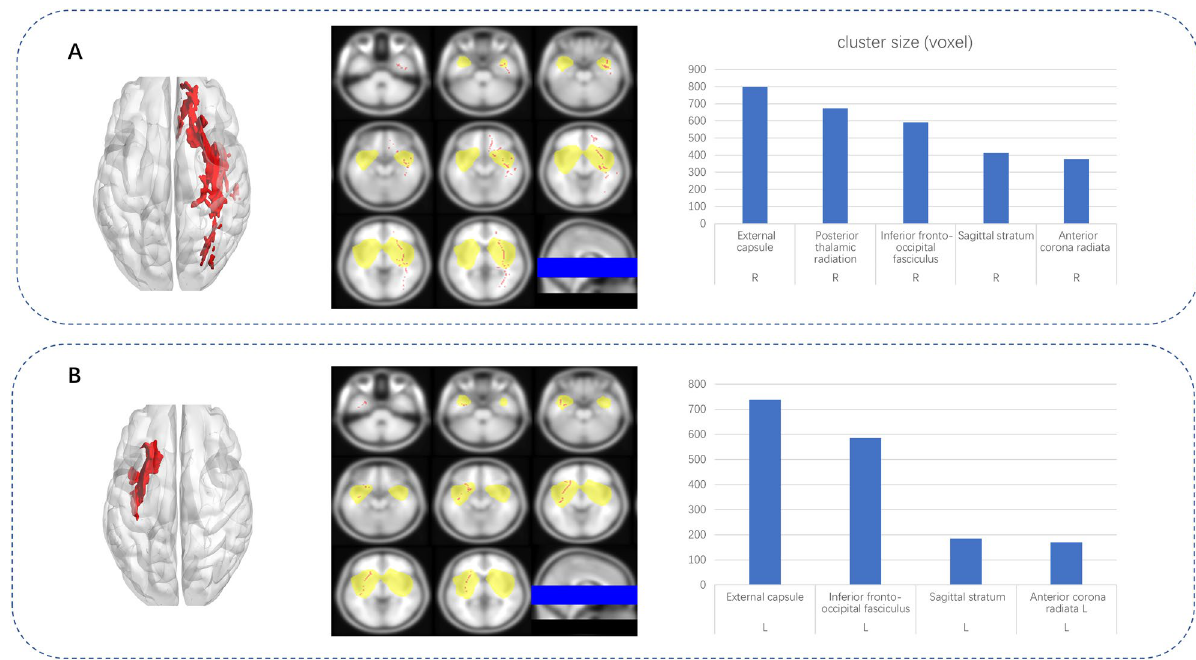
Figure 3. Fiber bundles with different diffusion metrics between the LGG and HGG groups, revealed by atlas- based analysis. A–F: Bar-dot figures showing group difference in six major fiber bundles. G: ROC analysis of all fibers with t < 0.01.